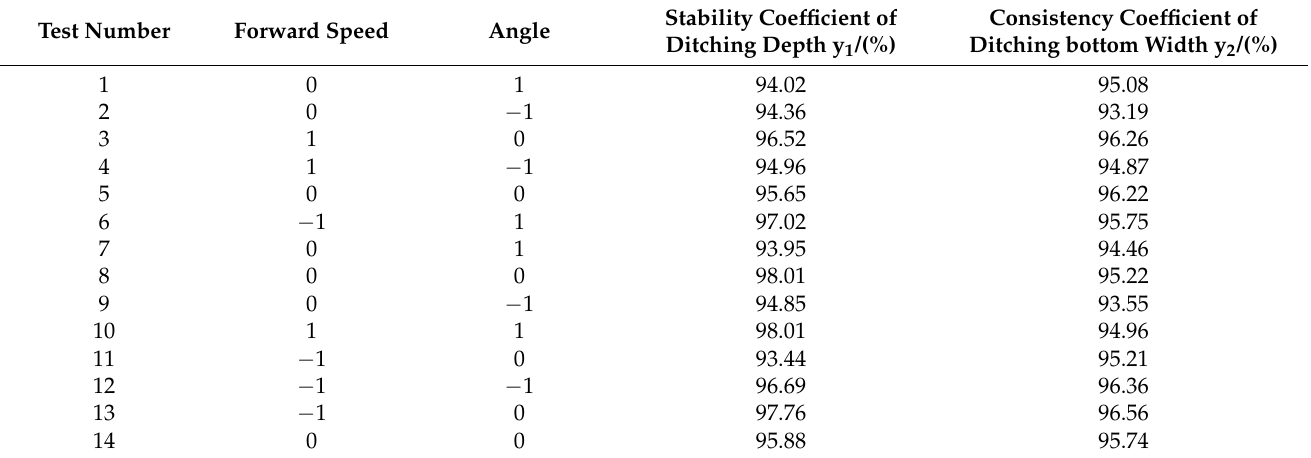
Table 4. Quadratic regression experimental design and response